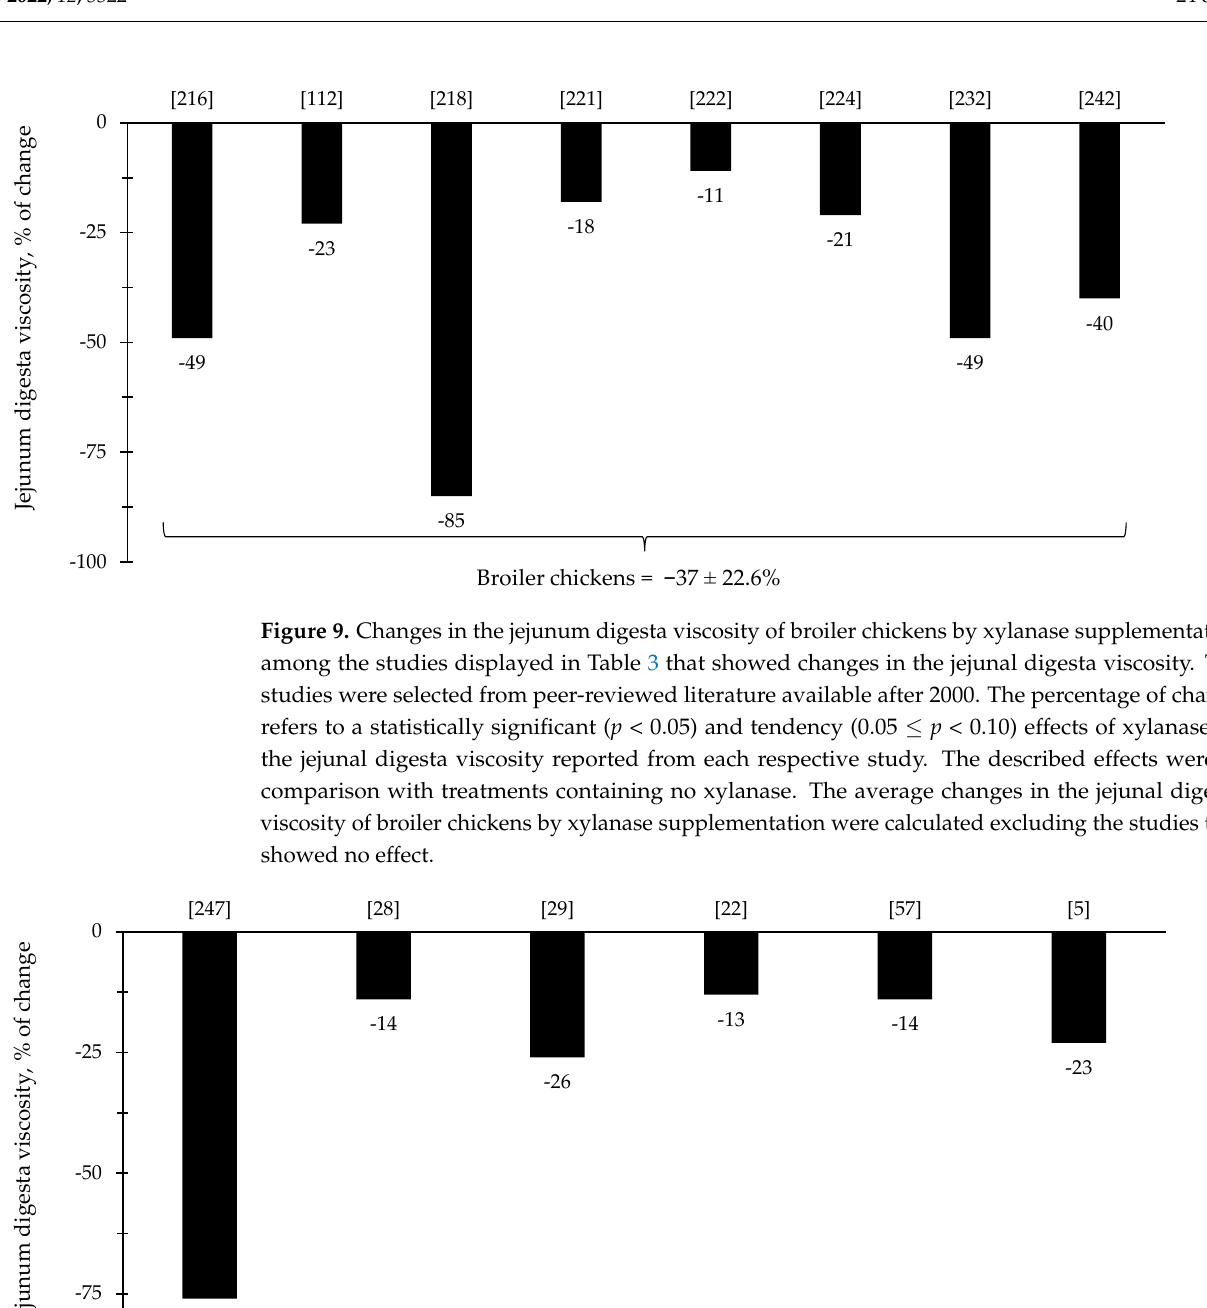
22 of 36 Figure 8. A list of the number of peer-reviewed papers found in the PubMed using different key- words. Black bars: xylanase, growth, pigs as key words; grey bars: xylanase, intestinal health, pigs as keywords. The reduction in digesta viscosity and increase in nutrient digestibility are described as some of the primarily established benefits of xylanase supplementation for pigs and broiler chickens. Most of the studies for broiler chickens showed consistent improvements related to the reduction in jejunal digesta viscosity (=37%), which may account for other benefits reported in each of the respective described studies (Figure 9). For nursery pigs,